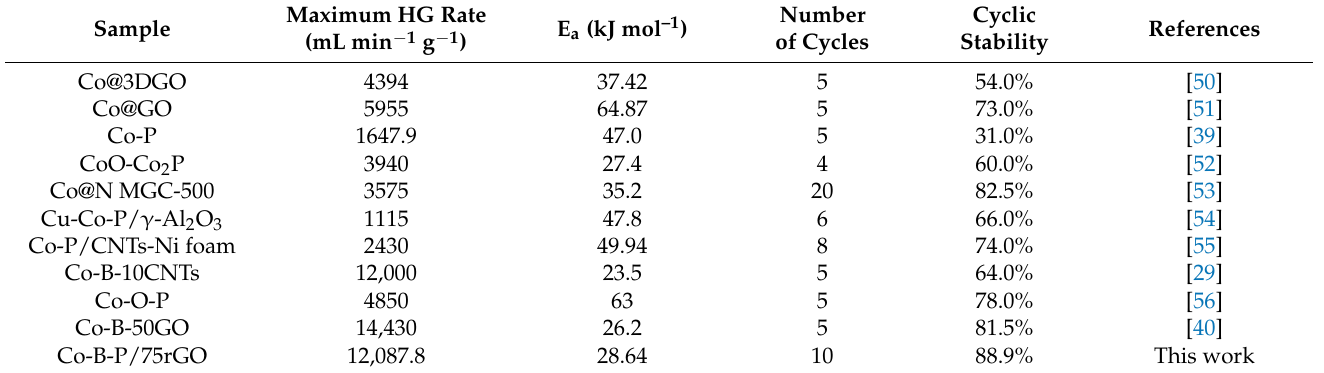
Table 2. The Co-B-P/75rGO catalyst was compared with those previously reported in the